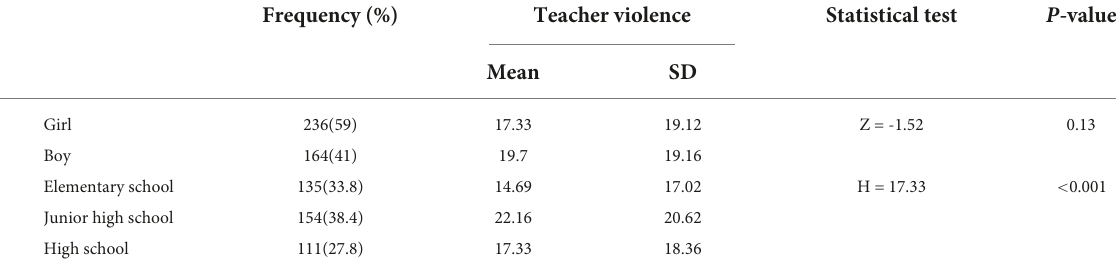
TABLE 2 The relationship between characteristics of students and teacher